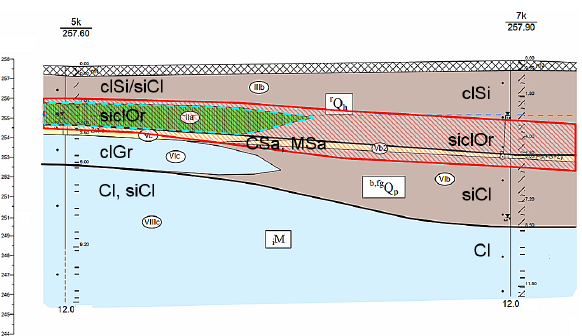
Figure 3: Geotechnical cross-section 5k-7k at the place of occurrence of irregular settlements in the transition zone. The zone of organic soil occurrence determined during the subsoil investigations is marked with a diagonal hatching, previous incorrect (incomplete) recognition with a dashed line.